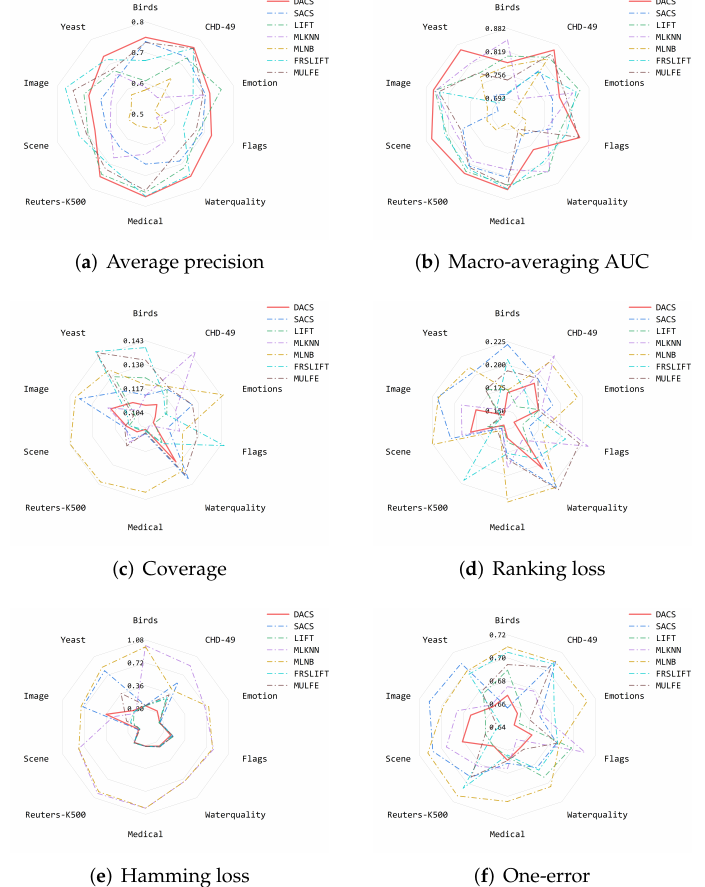
Figure 4. Spider web diagrams show the stability performance of compared algorithms with different evaluation